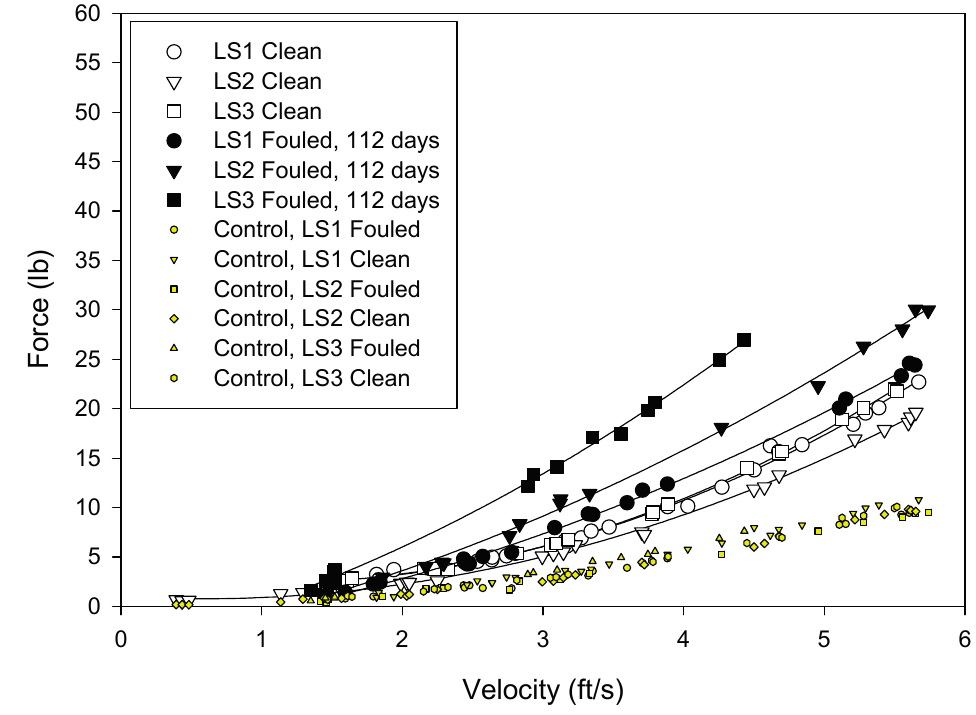
Figure 7. Drag forces measured on the silicone coated nets. White filled symbols represent clean nets and black filled symbols represent fouled nets. Shaded points without regression lines are the force readings on the control force gage (blank frame).